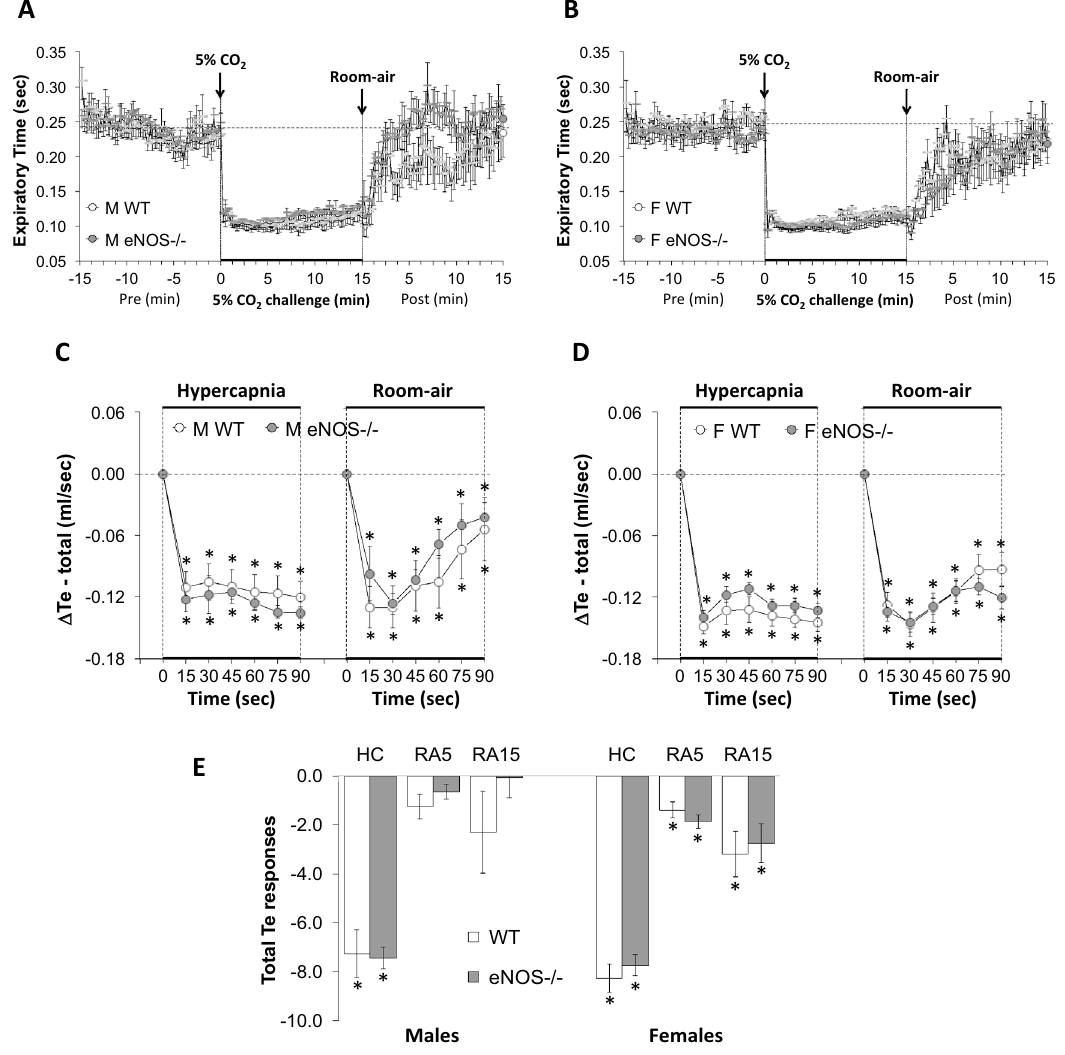
Figure 5. Panels ( A ) and ( B ) Expiratory time (Te) values before, during a hypercapnic (HC) gas challenge (5% CO 2 , 21% O 2 , 74% N 2 ) and upon return to room-air in male (M) and female (F) wild-type (WT) and eNOS knock-out (eNOS-/-) mice. Panels ( C ) and ( D ) Arithmetic changes in Te in male and female WT and eNOS-/- mice during the first 90 s of exposure to HC challenge and the first 90 s upon return to room-air. Panel ( E ) Total changes in Te in male and female WT and eNOS-/- mice during the HC challenge and during the first 5 min (RA5) and entire 15 min (RA15) return to room-air. The data are presented as mean ± SEM. * P < 0.05, significant change from pre-values. † P < 0.05, eNOS-/- versus WT within each